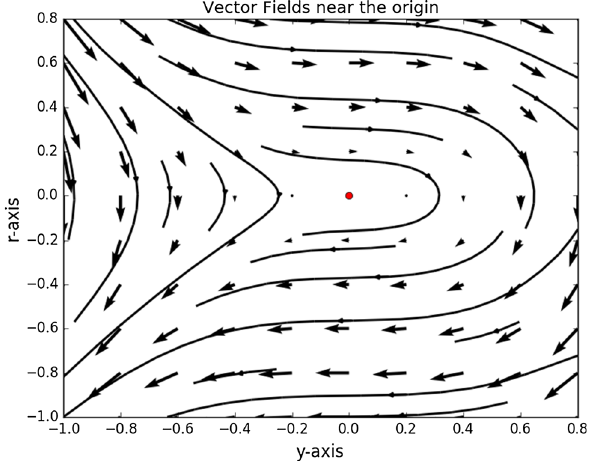
Fig. 5 For n odd, origin is a cusp (for Eqs. 38 and 39) Table 5 Stability analysis (for m > 2 and n > 2) Critical points H c